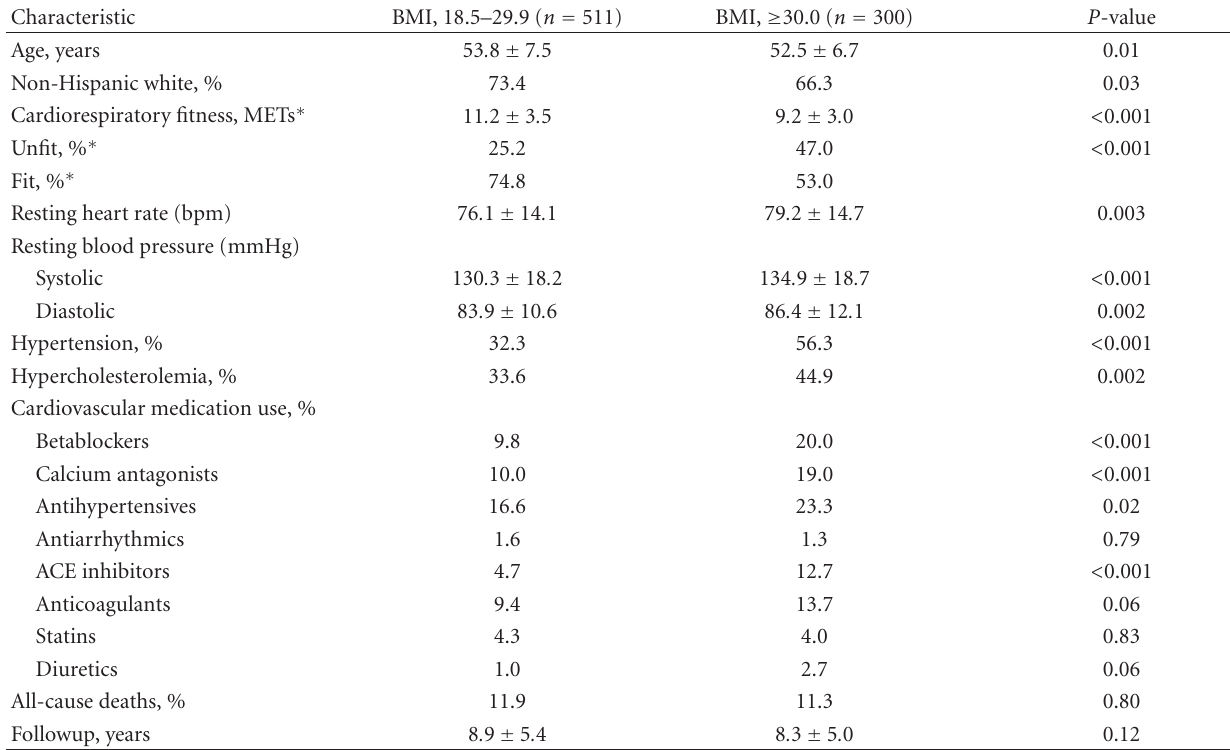
Table 1: Baseline characteristics of the study